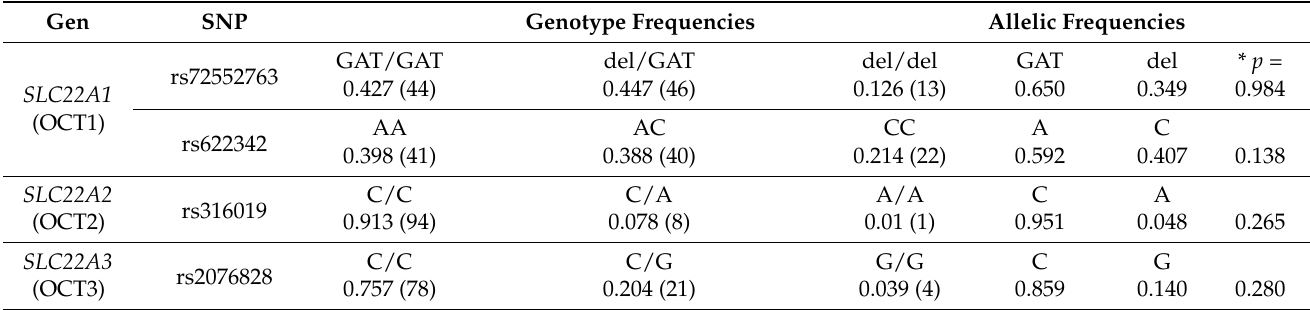
Table 2. Genotypic and allelic frequencies among DMT2 patients ( n =